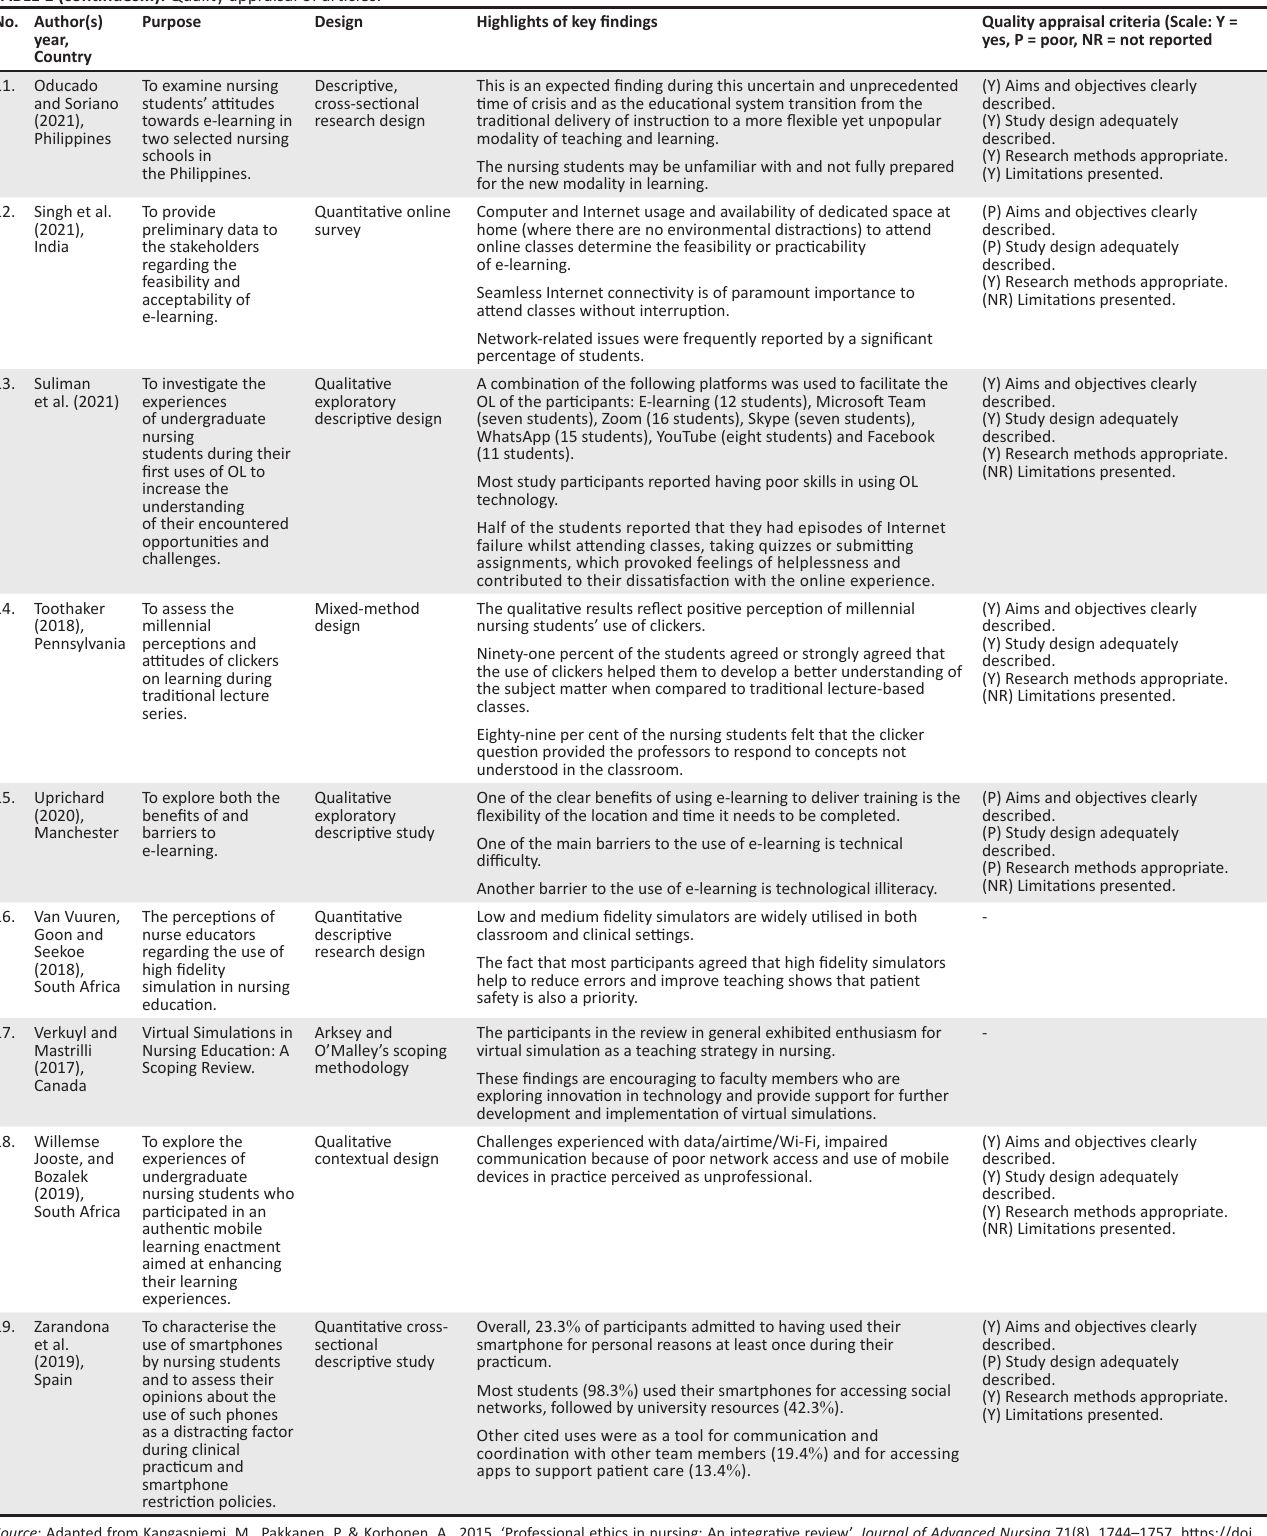
TABLE 1 (continues...): Quality appraisal of